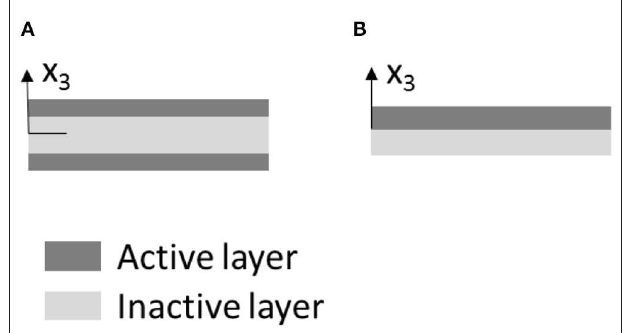
FIGURE 1 | Multi-layered active composites of different arrangements: (A) sandwich system and (B) bilayer of active and inactive materials.